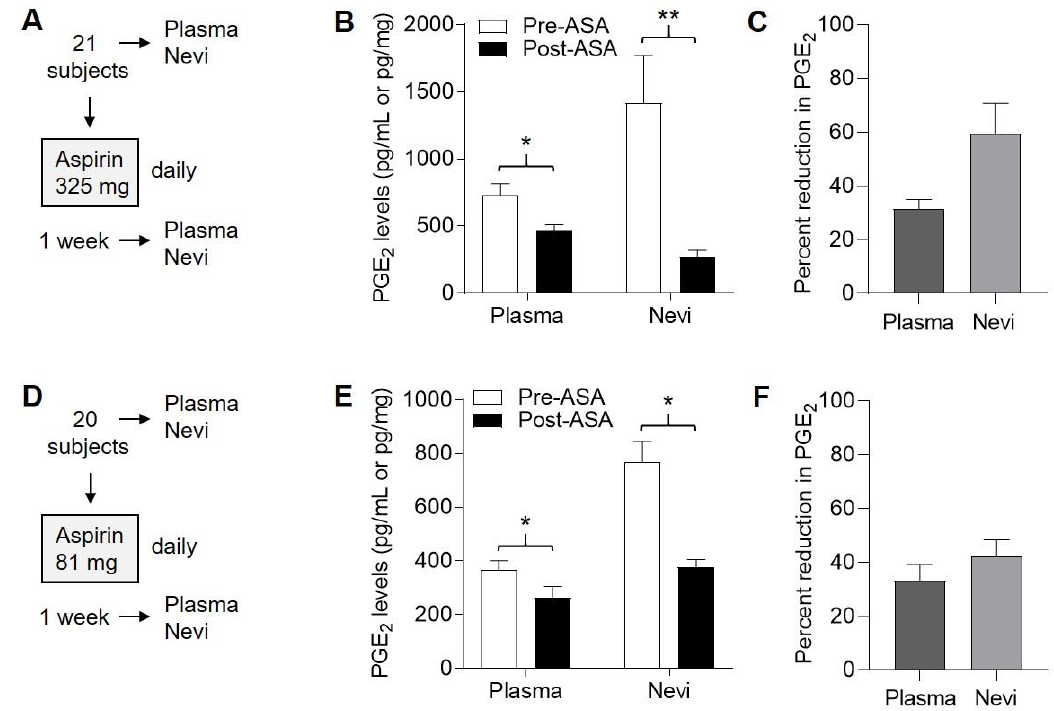
Figure 6. Suppression of PGE 2 in plasma and nevi following 1 week of daily ASA exposure. Human subjects were each given ASA daily for one week, and blood and nevus samples were obtained both before (pre) and after (post) this period. ( A ), Protocol for 325 mg dosing. ( B ), Levels of PGE 2 in plasma and nevi in the 325 mg cohort. Error bars represent SEM. * p < 0.0001, ** p = 0.004, paired t -tests. ( C ), Average percent reduction in PGE 2 levels from ( B ). Error bars represent SEM. ( D ), Protocol for 81 mg dosing. ( E ), Levels of PGE 2 in plasma and nevi in the 81 mg cohort. * p < 0.0001, paired t -tests. ( F ), Average percent reduction in PGE 2 levels from ( E ). Error bars represent SEM.